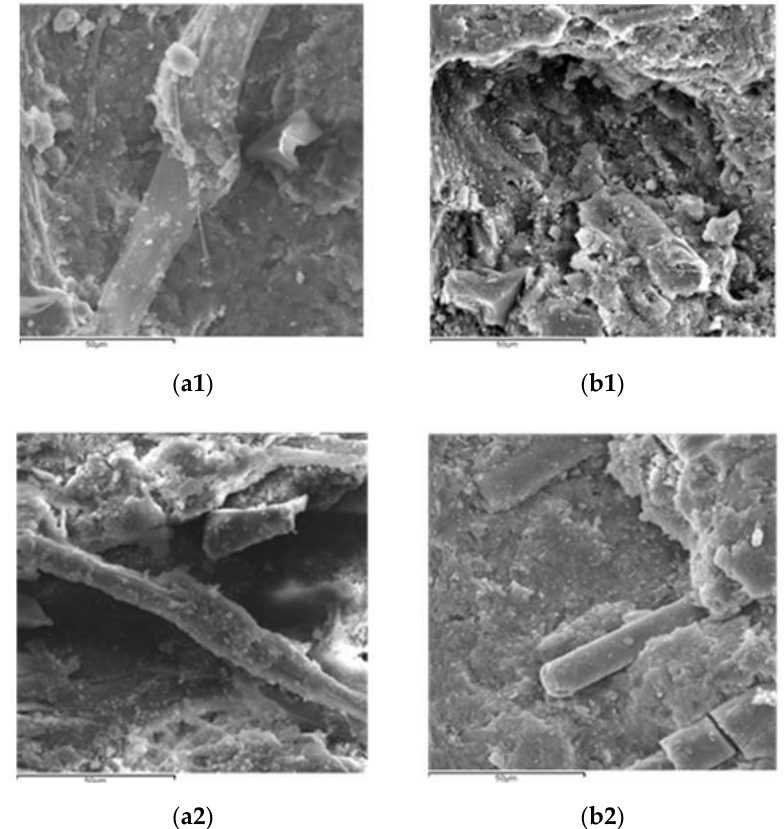
Figure 14. E ff ects of fire on fiber reinforced concrete, FRC with 1% fiber content, ( a1 ) unfired FRC-1%PF, ( a2 ) FRC-1%PF after 120 min of fire, ( b1 ) unfired FRC-1%BF, ( b2 ) FRC-1%BF after 120 min of fire.